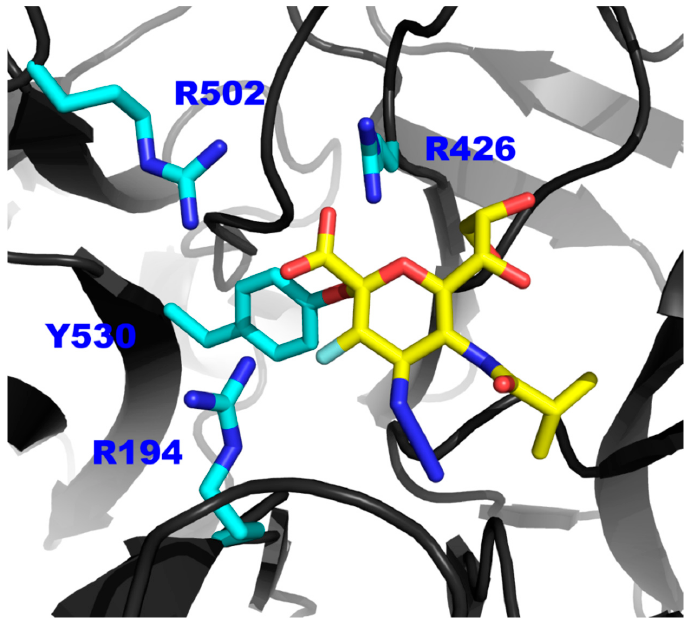
Figure 5. The proposed model of the interaction between inhibitor 3 and the Tyr530 of hPIV-1 HN. Representation of a hPIV-1 homology model (based on hPIV-3 co-crystal structure in complex with 3, PDB ID: 4XJR) [13] in complex with inhibitor 3 (yellow sticks). Side chains of the tri-arginyl cluster (R194, R426 and R502) and the key catalytic amino acid Tyr530 are shown in blue sticks.